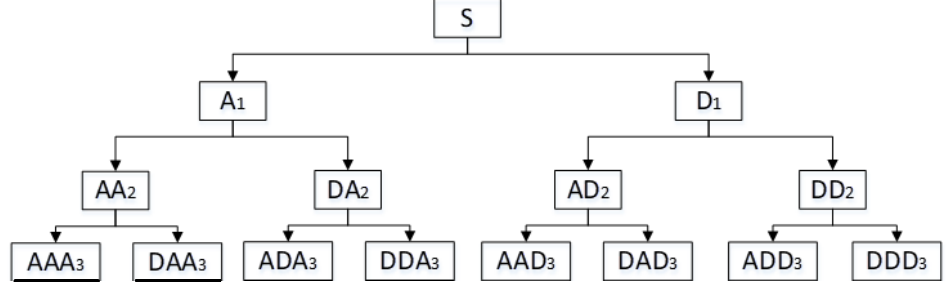
Figure 3. Schematic diagram of wavelet packet decomposition tree at level